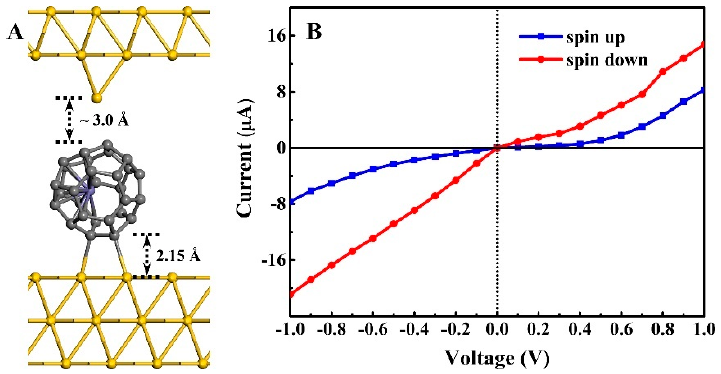
Figure 4. ( A ) Profile of the scanning tunneling microscopy (STM)-type Fe@C 28 junction. The nearest Au–C distance is 3.12 Å. ( B ) Spin resolved current–voltage (I-V) curves within the voltage region from − 1.0 to 1.0 V.